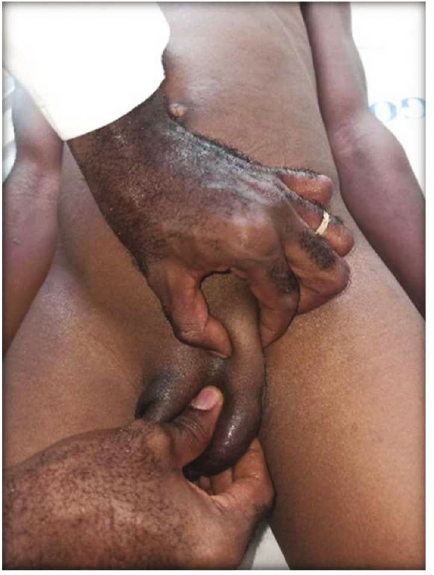
Figure 2: Examiner isolating two separate masses on the left path of testicular descent.